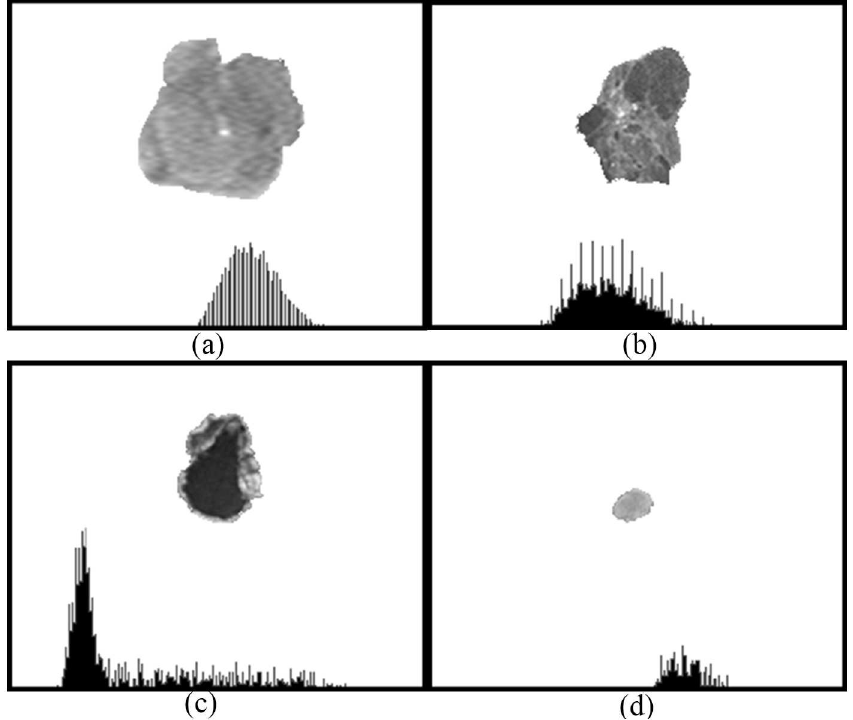
Fig 2. Image histograms showing gray-scale distributions of the delineated tumor areasin Fig 1. (http://cancerimagingarchive.net/ - "License"and the CC BY license(https://creativecommons.org/licenses/ by/3.0/, tumor areas in this figure were extracted from